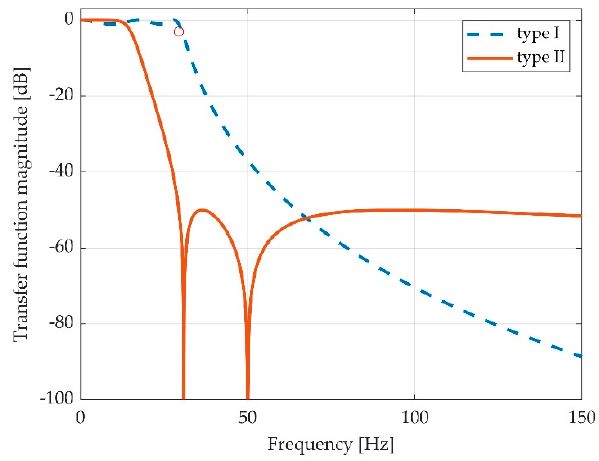
Figure 6. The low pass Chebyshev filter type II frequency response (in orange line) versus same filter of type I frequency response (in blue interrupted line).